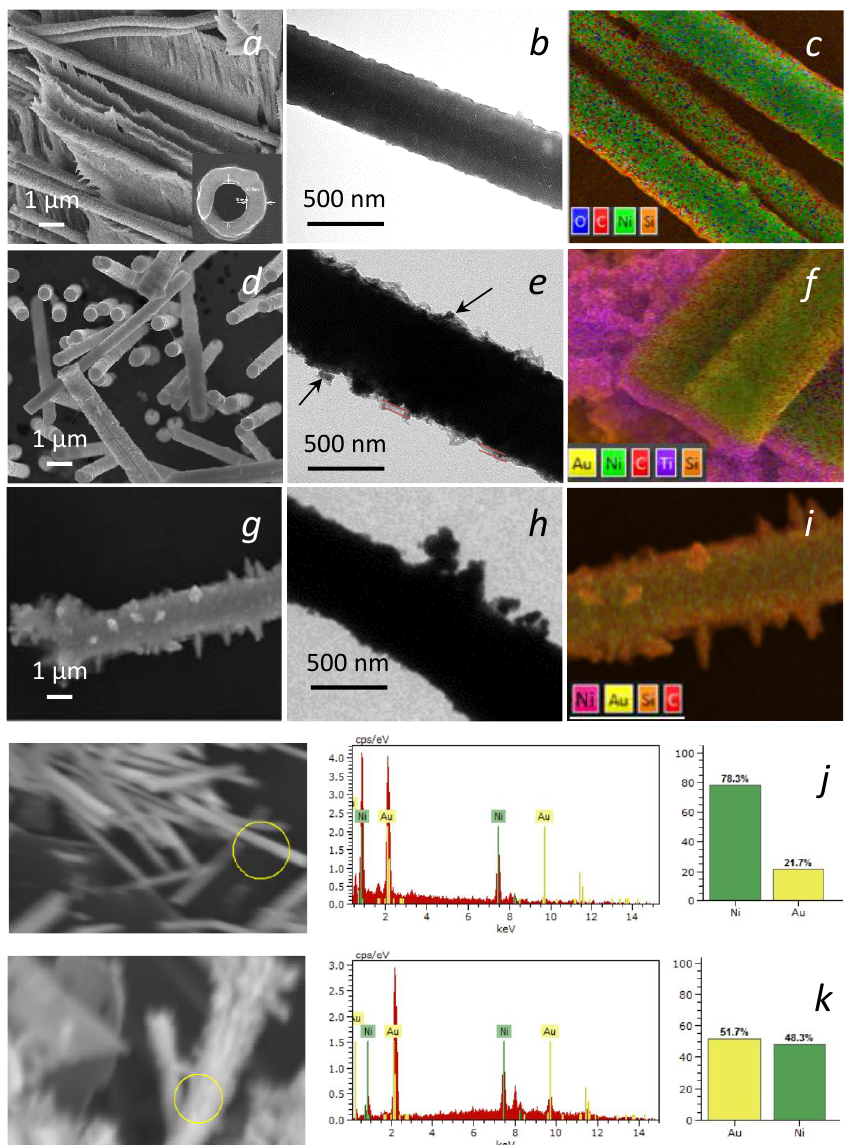
Figure 1. Images and elemental content mapping of fabricated structures . Nickel NTs: SEM ( a ), TEM ( b ) and EDX-mapping ( c ). Ni@Au with thin gold layer: SEM ( d ), TEM ( e ), EDX-mapping ( f ), and elemental composition ( j ). Ni@Au with gold needles: SEM ( g ), TEM ( h ), EDX-mapping ( i ), and elemental composition ( k ).